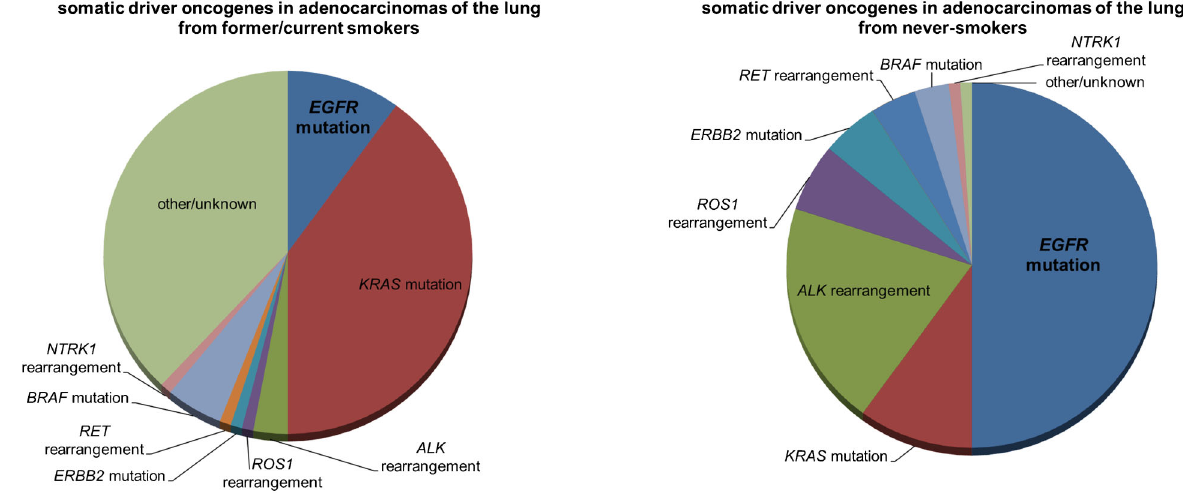
Figure 1. Pie chart of the frequency of driver oncogene mutations in lung adenocarcinomas from former/current smokers (left panel) and from never-smokers (right panel). Note the striking difference between the higher frequency of EGFR, ALK, ROS1, ERBB2, RET, BRAF (V600E), and NTRK1 mutations in never-smokers, and the higher frequency of KRAS mutations in